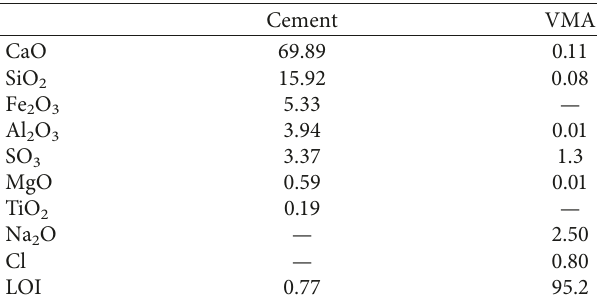
Figure 4: (a) General geometry and (b) detail of the notch and crack used in the finite element simulations (scale factor: 200). Table 1: XRF chemical composition of cement and VMA (LOI: loss on ignition).